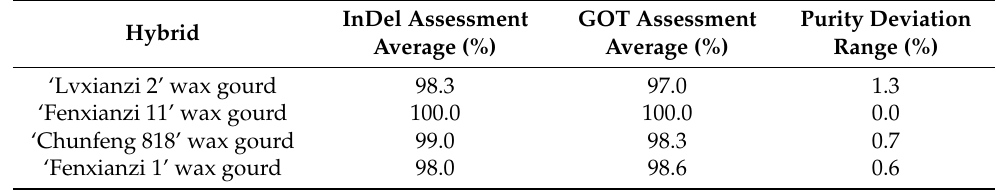
Figure 12. Purity identification of some plants of ‘Fenxianzi 1 ′ wax gourd by PS14. M: DL2000 DNA Marker; P 1 : YSB-1-1-2 (white peel); P 2 : GF-7-1-1 (green peel); 1–30: ‘Fenxianzi 1 ′ wax gourd. Table 4. Comparison of field grow-out trials (GOT) and InDel molecular marker purity test for wax gourd.